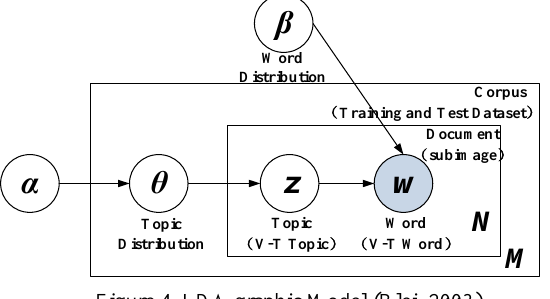
Figure 4. LDA graphic Model (Blei,